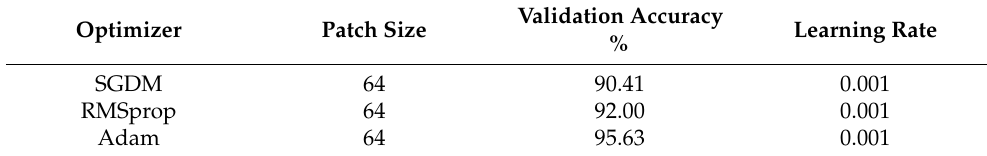
Table 3. CNN’s performance comparison for different